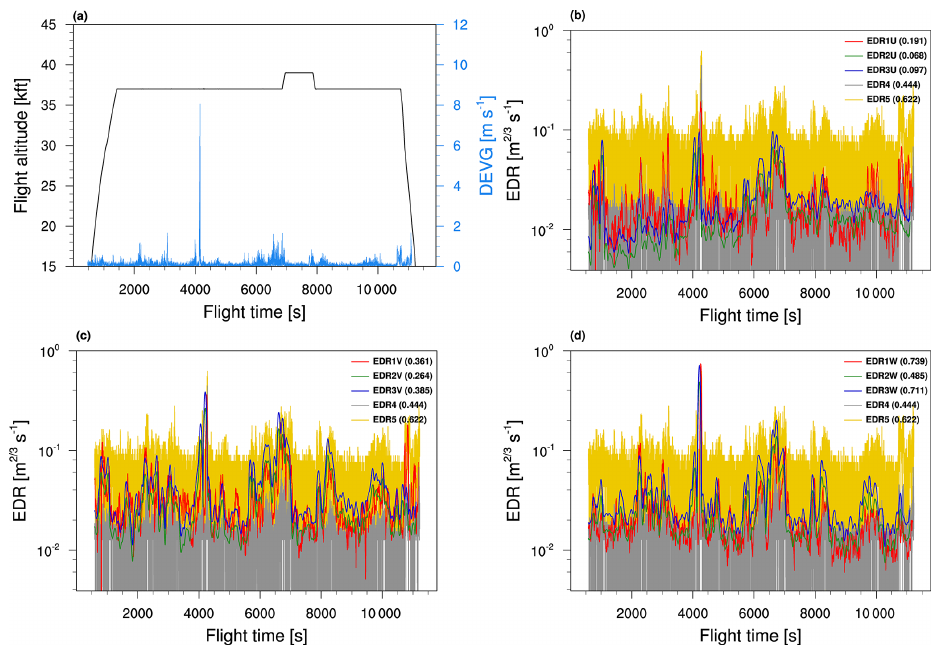
Figure 11. Time series of (a) flight altitude and DEVG and (b–d) EDR estimates obtained from the QAR data on 20 September 2012. The maximum value of the EDR is written in parentheses.